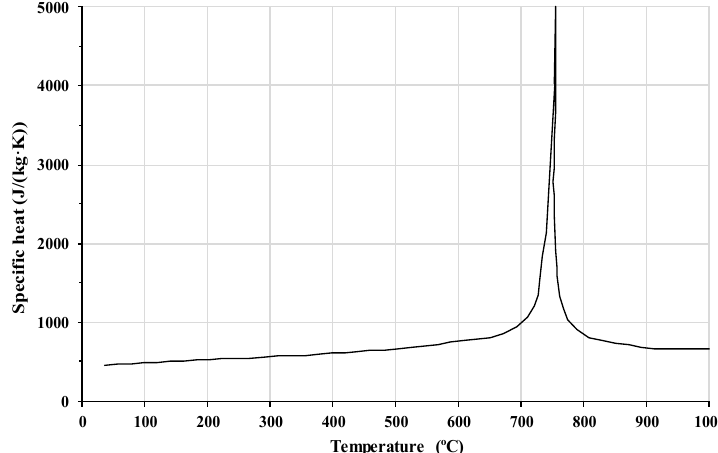
Figure 6. Specific heat of carbon steel as a function of temperature.